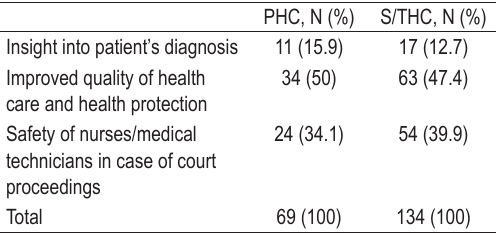
TABLE 3. Advantages of submitted nursing documentation